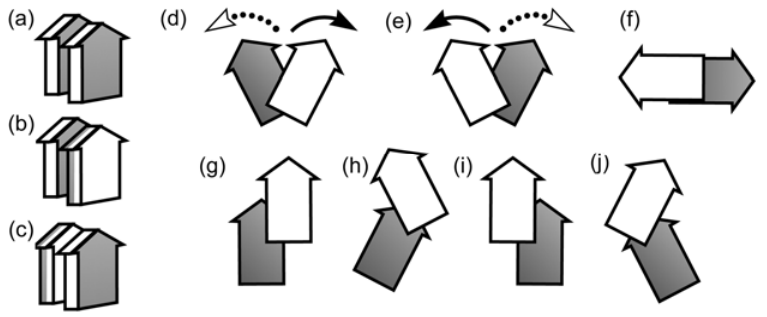
association modes with a head-to-head mode in addition to a belly-to-back (a), belly-to- belly (b), back-to-back (c) modes. Inclination between two materials with right-tilt (d), left-tilt (e), rotation by 90 degrees (f). Combination of sliding and tilt; right and up sliding (g), left-tilt after the right and up sliding (h), left and up sliding (i), right-tilt after the left and up sliding